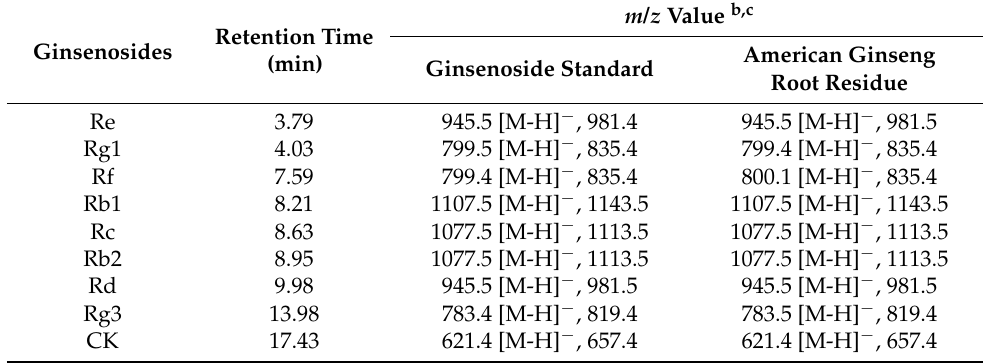
Table 1. The m / z value of ginsenoside standards and ginsenosides in American ginseng root residue extract by HPLC-MS a .